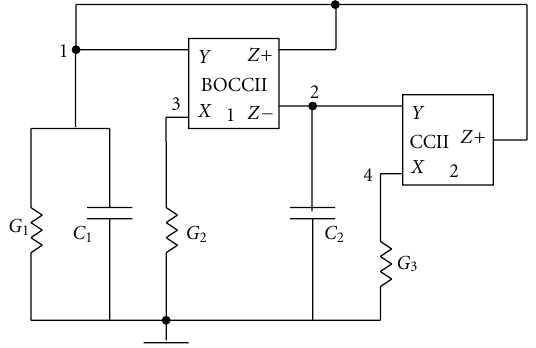
Figure 6: Realization I of class II type-A oscillator [17].